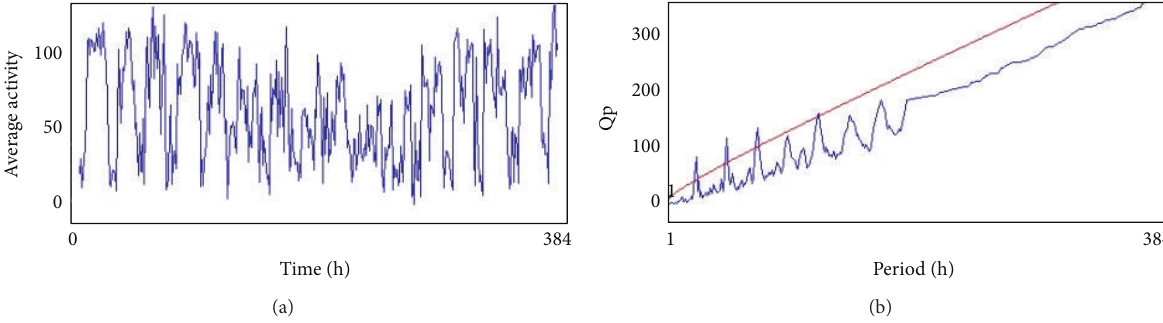
Figure 7: (a) and (b) show the average activity pattern and chi-square periodogram, respectively, for the PD flies exposed to 10 −3 molar dopamine in diet ( 𝑁 = 20 ).